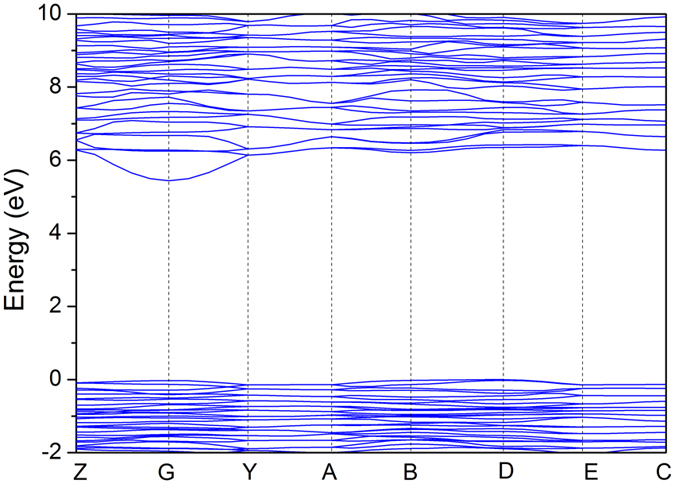
The band structure of KLa(PO3)4.